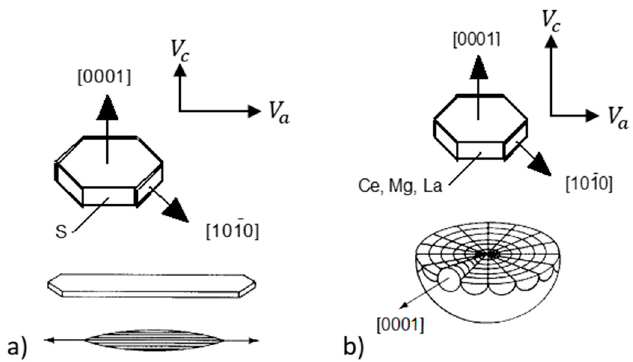
Figure 29. Change in the growth velocity of graphite, due to adsorption of impurity atoms: ( a ) Pure environment; ( b ) environment contaminated with reactive impurities (Mg, Ce, La); adapted after [116].